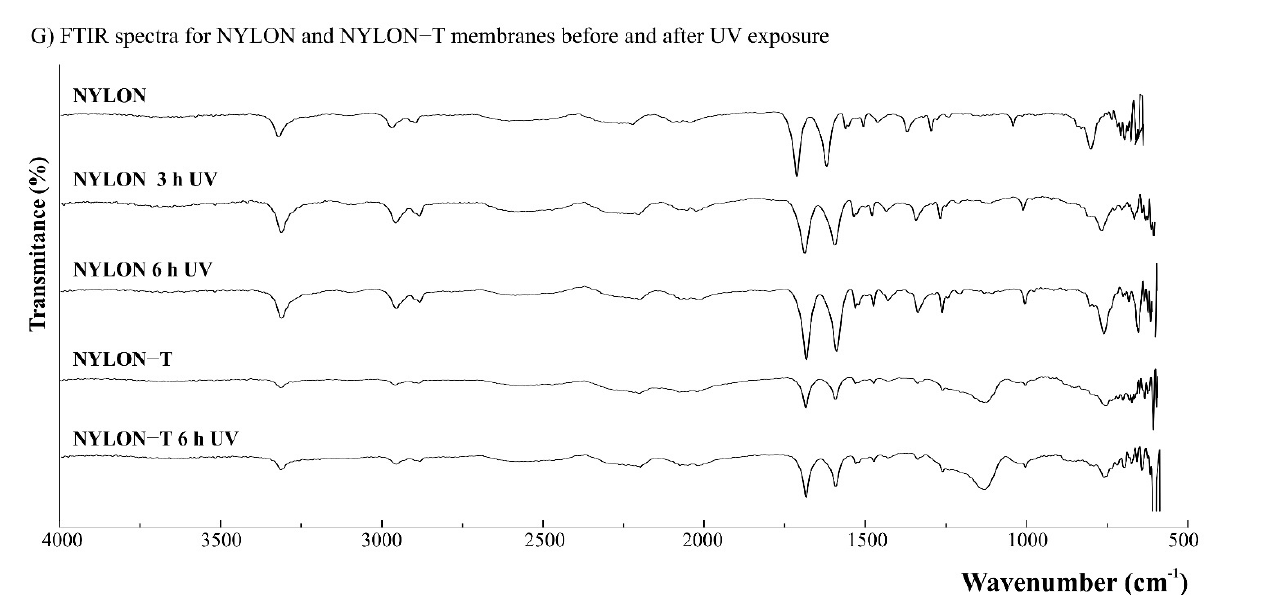
Figure 6. ( A – D ) SEM images for NYLON (polyamide–nylon, 0.45 µm) and NYLON-T (NYLON modified with TiO 2 ) membranes before and after UV exposure (magnification ×3000), ( E ) NYLON-T EDS, ( F ) EDS mapping showing the Ti distribution on the membrane surface after 6 h of UV exposure, and ( G ) Fourier transform infrared spectroscopy (FTIR) spectra for NYLON and NYLON-T membranes before and after 3 and 6 h of UV radiation.